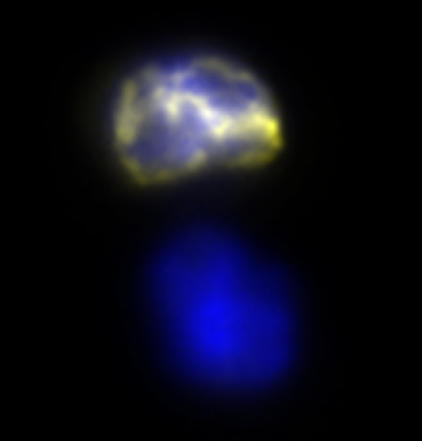
When stem cells divide, the sister chromatids containing the older template DNA strands (yellow) may all segregate to one daughter cell, reflecting the different fates of the progeny of that cell division.